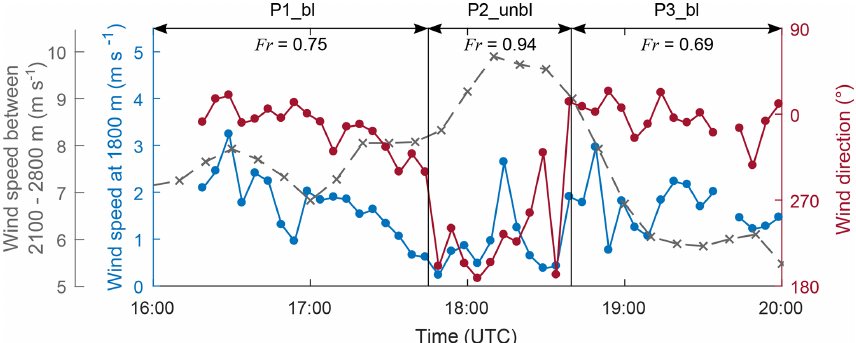
Figure 7. Temporal evolution of the horizontal wind speed (blue) and wind direction (red) at Wolfgang obtained from the wind lidar mea- surements at an altitude of 1800m. The mean wind speed between 2100 and 2800m (gray) measured by the wind profiler at Wolfgang is shown as a proxy for the strength of the downward-propagating cross-barrier flow. The Froude numbers ( Fr ) for the different periods are indicated at the top (see Appendix A for